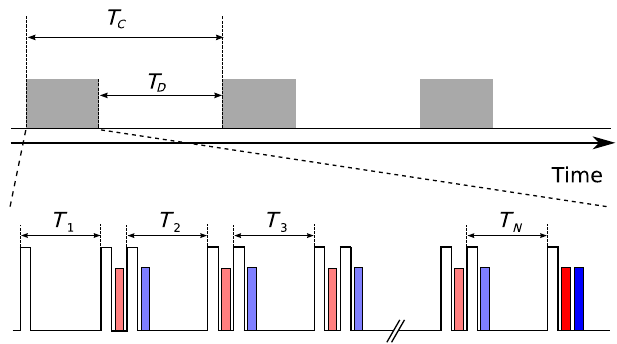
FIG. 6. Protocol for atomic clock with PLL. Operation of the clock: At each cycle of duration T , the relative phase is C repeatedly measured in a coherence-preserving way during the phase-lock interval (above: shaded gray areas). Each interrog- ation, represented in the inset by a light red peak between the ð i Þ manipulation π = 2 pulses, is followed by a phase correction φ FB on the LO, represented in the inset by a light blue peak on the right after the reintroduction of the spin on the equatorial plane of the Bloch sphere. The final phase readout φ (dark red peak in the f inset), whose SNR is set by the residual coherence, together with the previously applied phase shifts on the LO, provides the total phase drift φ experienced during the extended interrogation ¼ N × T . The interrogation sequence ends with interval T tot the application of a frequency correction on the LO (dark blue peak in the inset); then, a new atomic ensemble is prepared in the dead-time interval T for the next D